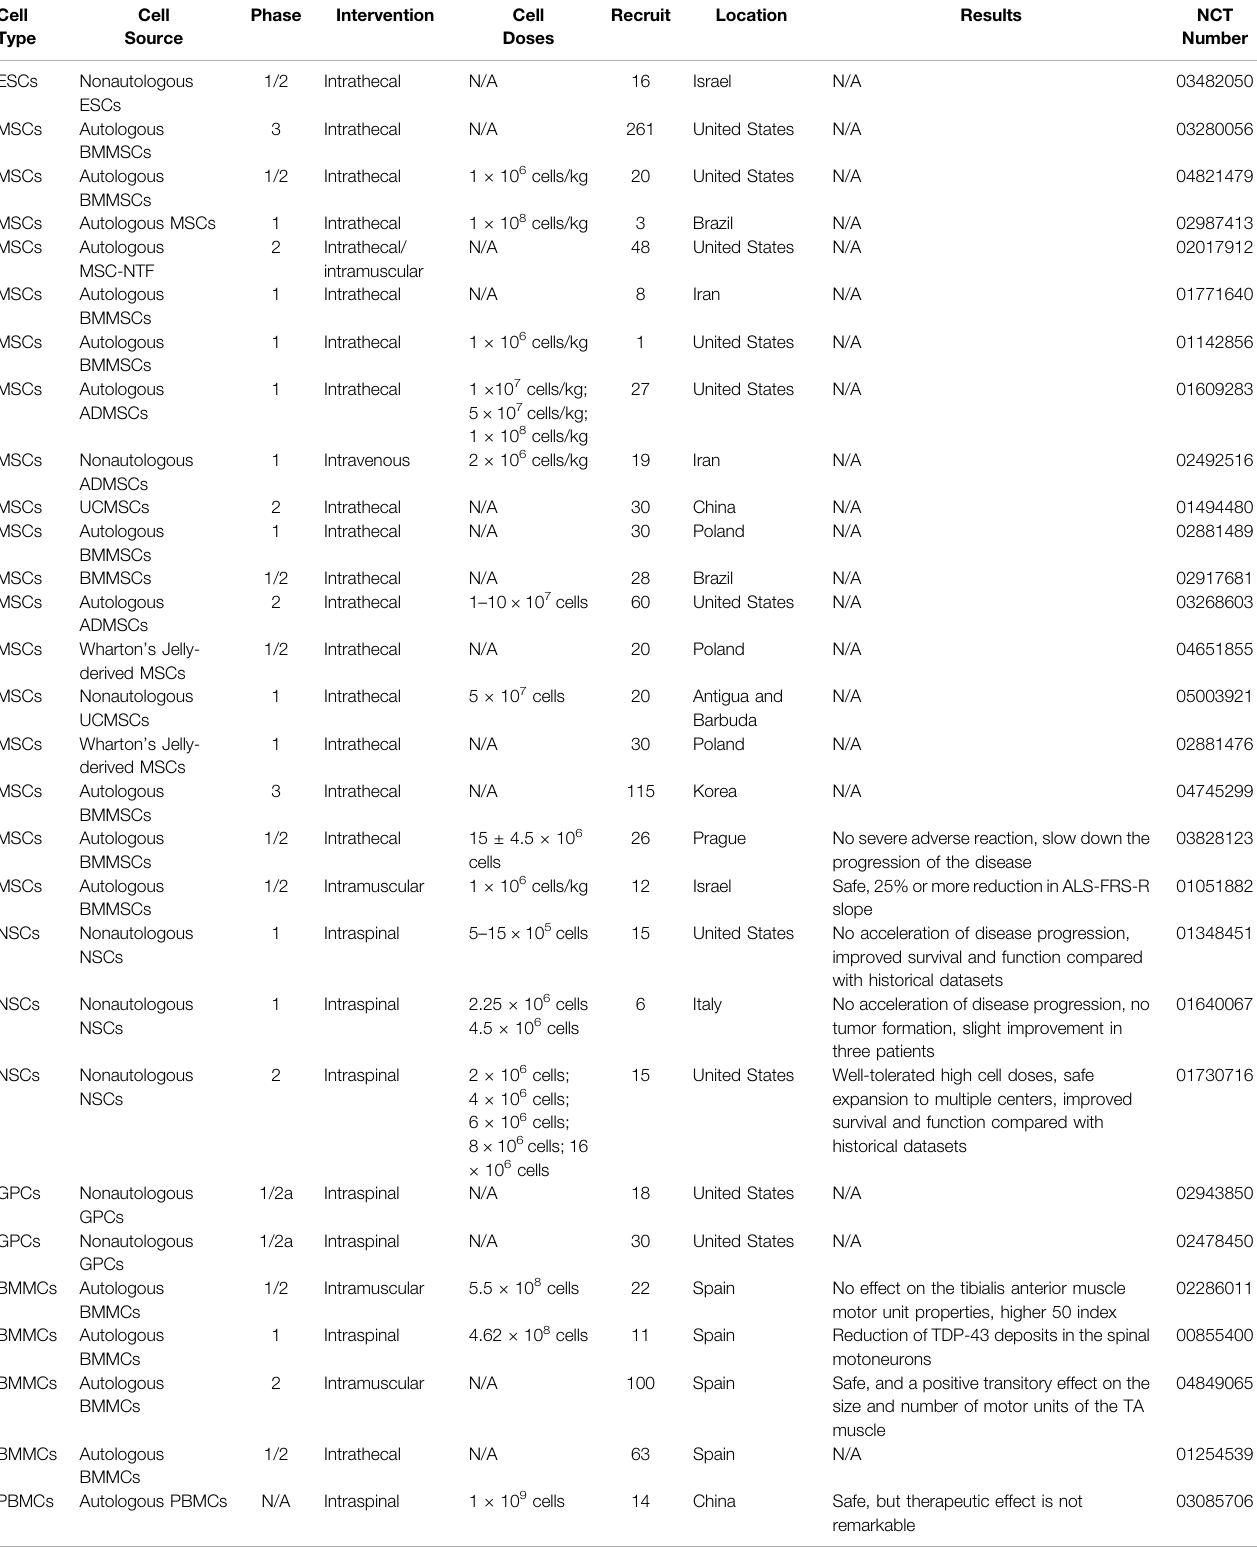
TABLE 3 | Clinical trials of cellular therapy in ALS